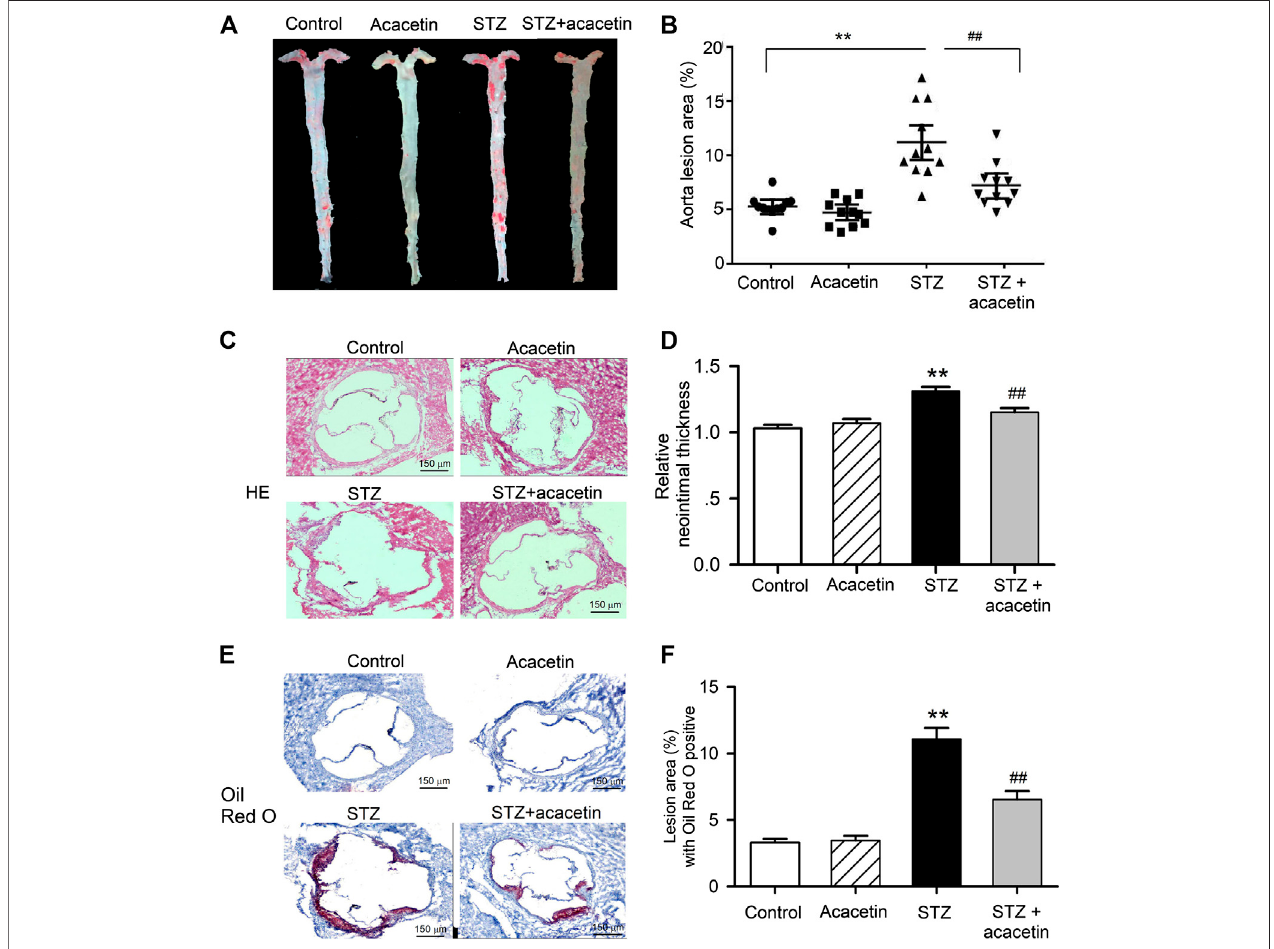
FIGURE 7 | Acacetin attenuates STZ-induced atherosclerosis in STZ-diabetic ApoE − / − mice. (A) Oil Red O staining of mouse aortas in control, with acacetin treatment,STZ, andSTZwithacacetintreatment. (B) AnalysisofaortalesionareasstainedwithOilRed OinA. (C) HEstainingofaorticrootsection frommiceincontrol, with acacetin, STZ, and STZ with acacetin treatment. (D) Analysis of neointimal thickness in C. (E) Oil Red O staining of the same aortic root sections from mice as in C. (F) Lesion area of aortic root section with Oil Red O positive in E ( × 4 magni fi cation). n (cid:2) 11 ** p < 0.01 vs. control or acacetin; ## p < 0.01 vs. STZ.